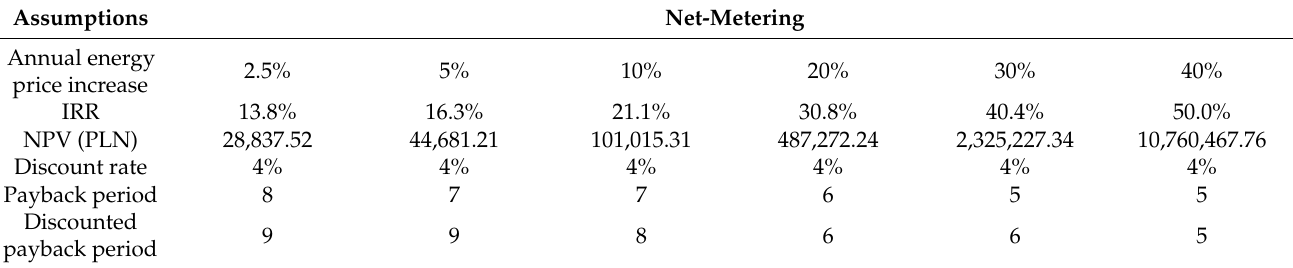
Table 2. Financial analysis results for net metering.